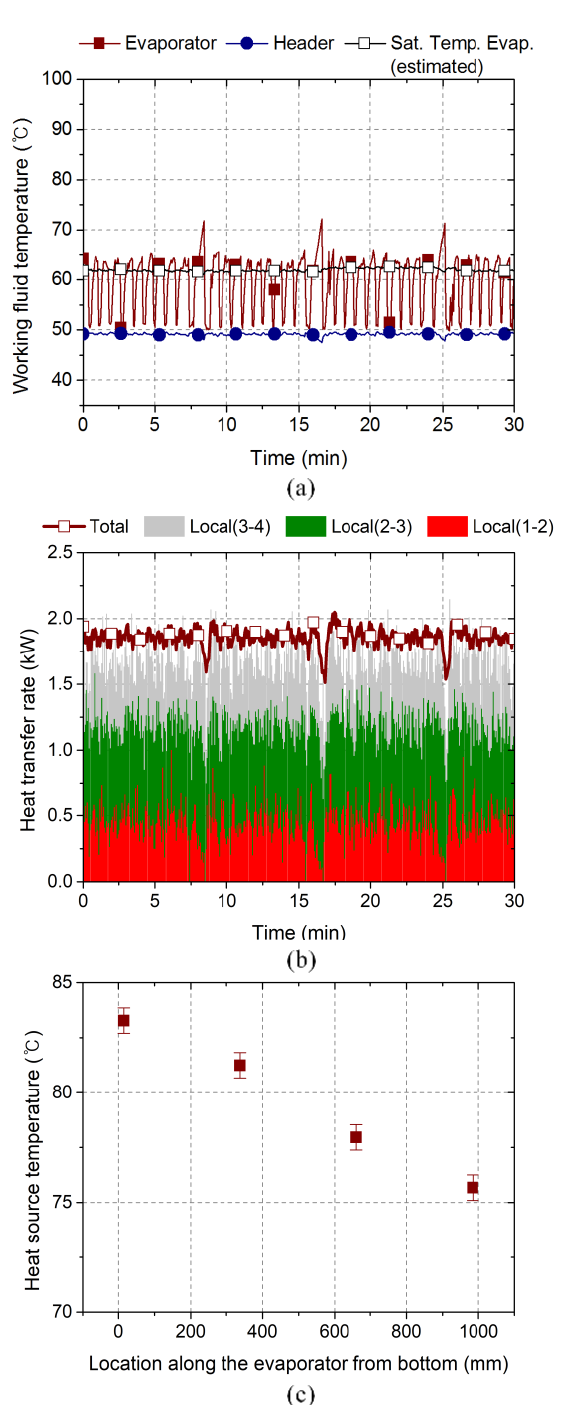
Figure 17. Operating characteristics of an FHP with a heat source temperature of 83.1 ◦ C: ( a ) working fluid temperature, ( b ) cumulative heat transfer rate, and ( c ) local heat source temperature.